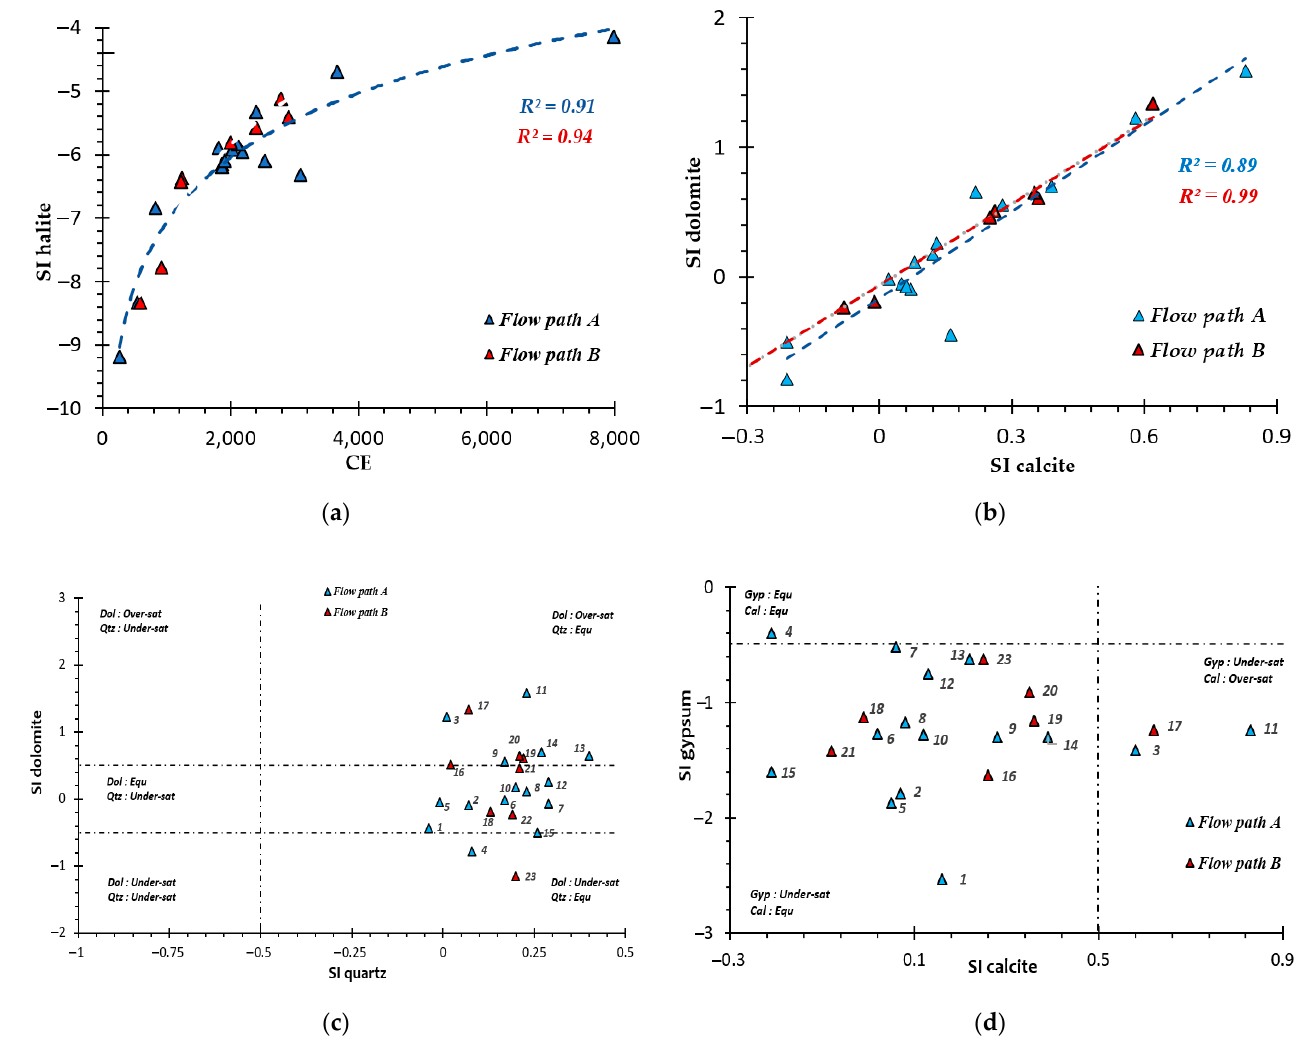
Figure 6. Saturation indices (SI) of calcite, dolomite, quartz, halite and gypsum for the various groundwater samples. ( a ) SI of halite versus electrical conductivity; ( b ) SI of calcite versus SI of dolomite; ( c ) SI of dolomite versus SI of quartz; ( d ) SI of calcite versus SI of gypsum. Dol = dolomite, Cal = calcite, Qtz = quartz, Gyp = gypsum, EQU = equilibrium, Under-sat. = undersaturation and Over-sat = oversaturation.